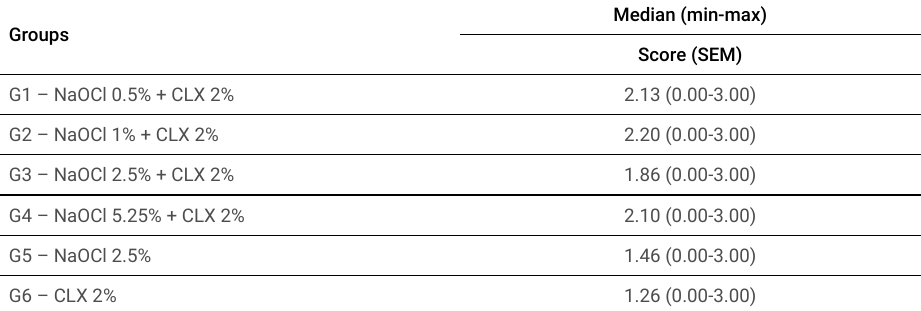
Table 2. Score values for the presence of precipitate on the dentin surface in the three thirds of the different groups. Kruskal-Wallis test p <0.05. Groups